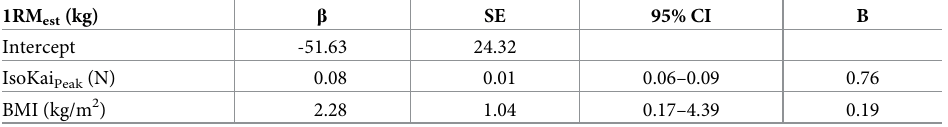
Table 3. Means of the IsoKai Peak and the associated estimated 1RM (1RM est ) deadlift weights. IsoKai Peak 1RM est Diff Diff kg (SD) kg (SD) kg (SD) % All ( n = 44 ) 136 (32) 108 (31) 27 � (18) 20 Males ( n = 28 ) 153 (24) 123 (27) 30 � (21) 20 Females ( n = 16 ) 105 (16) 80 (16) 24 � (10) 23 Diff; difference between the IsoKai Peak and the 1RM est weight derived from the 5-10RM DL tests, SD; standard deviation. � significant difference (p < 0.001).